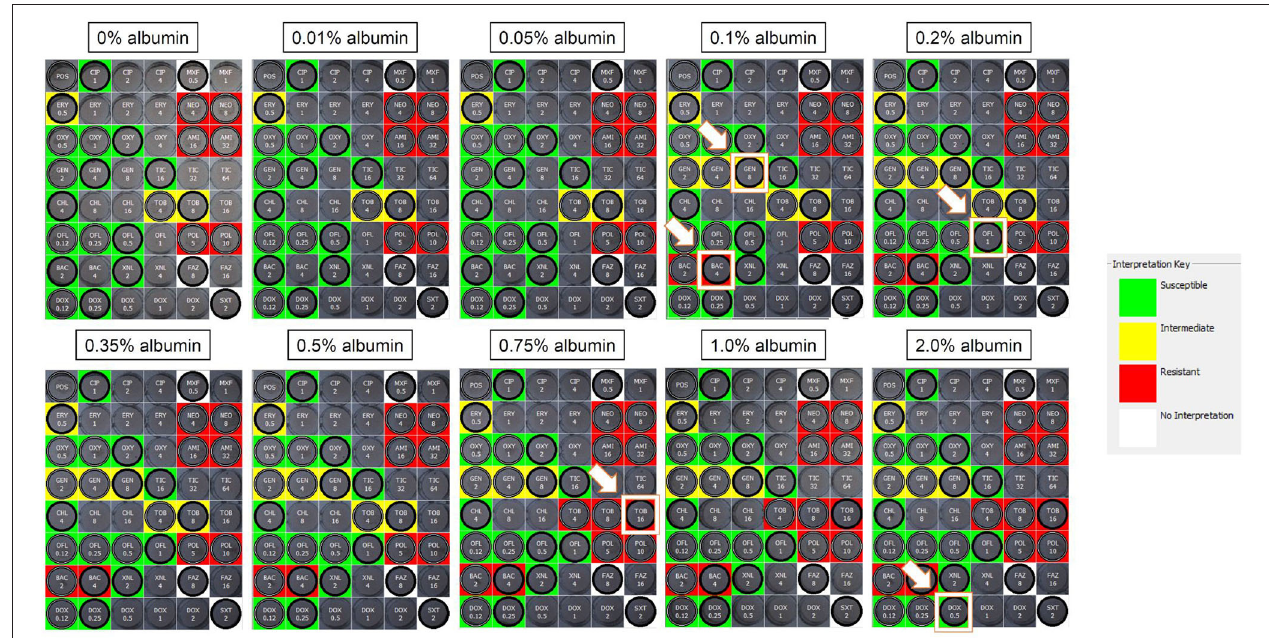
FIGURE 1 | Sensititre TM JOEYE2 plates assessing the MICs of ophthalmic antibiotics against Streptococcus canis in the absence (0%) or presence of albumin (0.01–2%). Wells highlighted by a white border and white arrow represent an increased MIC from the previous albumin level. In this example, MICs increased by 2-fold for gentamicin (4–8 µ g/ml), bacitracin (2–4 µ g/ml), ofloxacin (0.5–1 µ g/ml), tobramycin (8–16 µ g/ml), and doxycycline (0.25–0.5 µ g/ml), shifting the clinical interpretations from susceptible to resistant for bacitracin, susceptible to intermediate for gentamicin, and intermediate to resistant for tobramycin. MIC, minimal inhibitory concentration; Green, susceptible; Yellow, intermediate; Red, resistant; White,